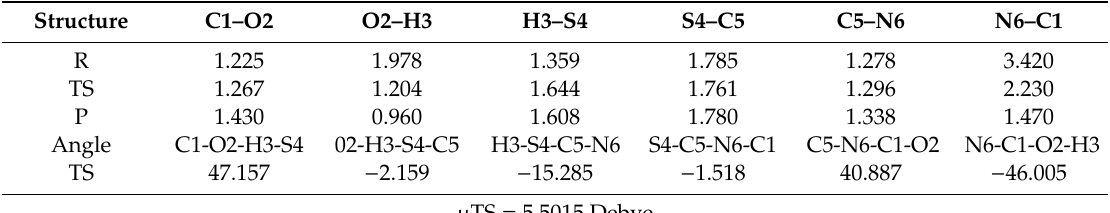
Table 4. Structural parameters for R, TS, and P, involved in the Biginelli reaction, from the